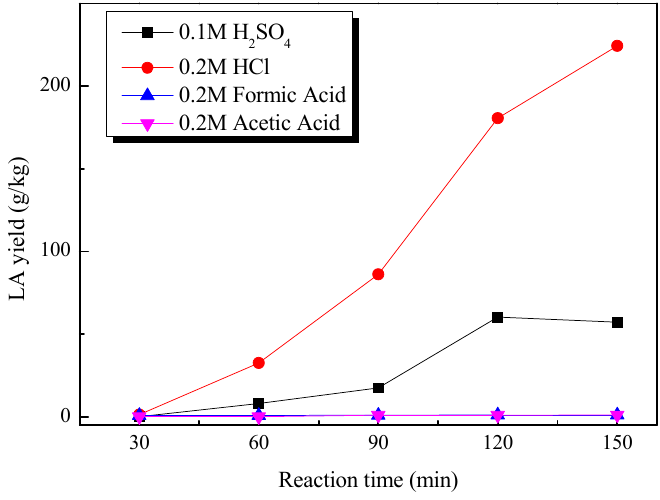
Figure 2. Production of LA from pretreated cow dung catalyzed by different liquid acid catalysts (reaction conditions: 0.3 g pretreated cow dung, acid aqueous solution 10 mL, 180 °C).